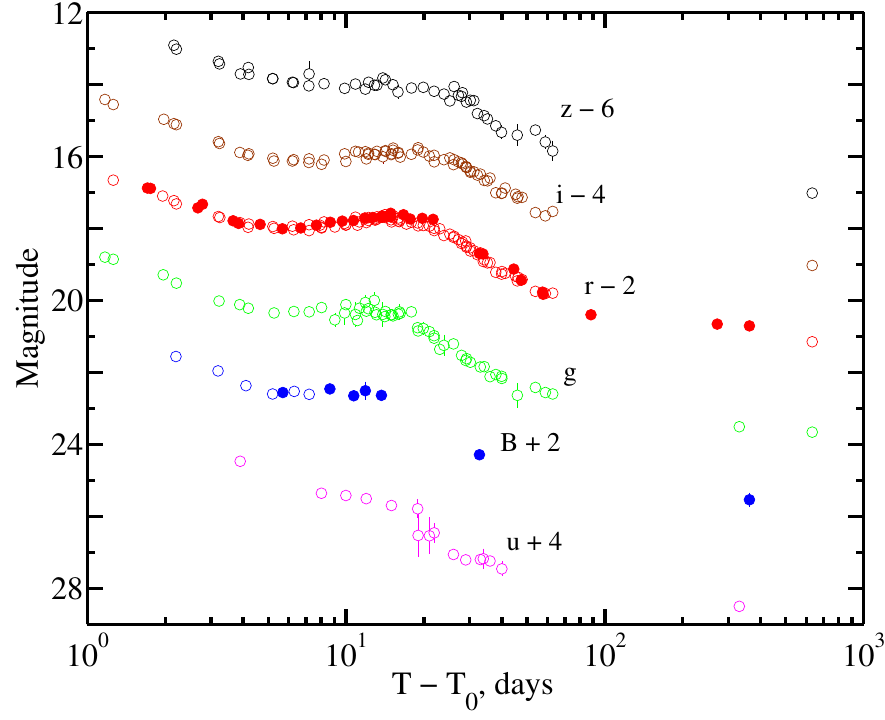
Figure 4. Multicolor light curve of GRB 130702A and associated supernova SN 2013dx, constructed from IKI GRB-FuN data and data from the literature (adopted from (Volnova et al. 2017).) Data obtained by our network are shown with filled